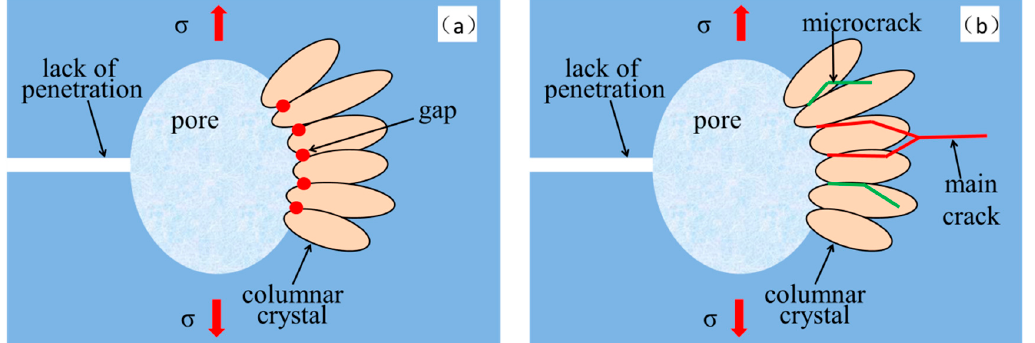
Figure 14. Fatigue-crack initiation mechanism at pore: ( a ) fatigue-crack initiation at the intersection of columnar grain boundary and pore; and, ( b ) crack propagation after initiation.